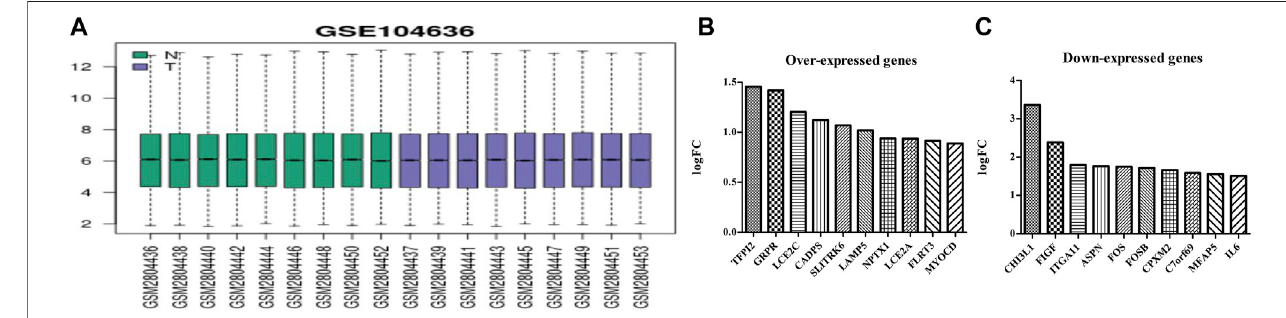
FIGURE 1 | Sample quality and gene expression in lung cancer tissues of the GSE104636 dataset. (A) Sample quality; (B) Overexpressed genes; (C) Under- expressed genes.